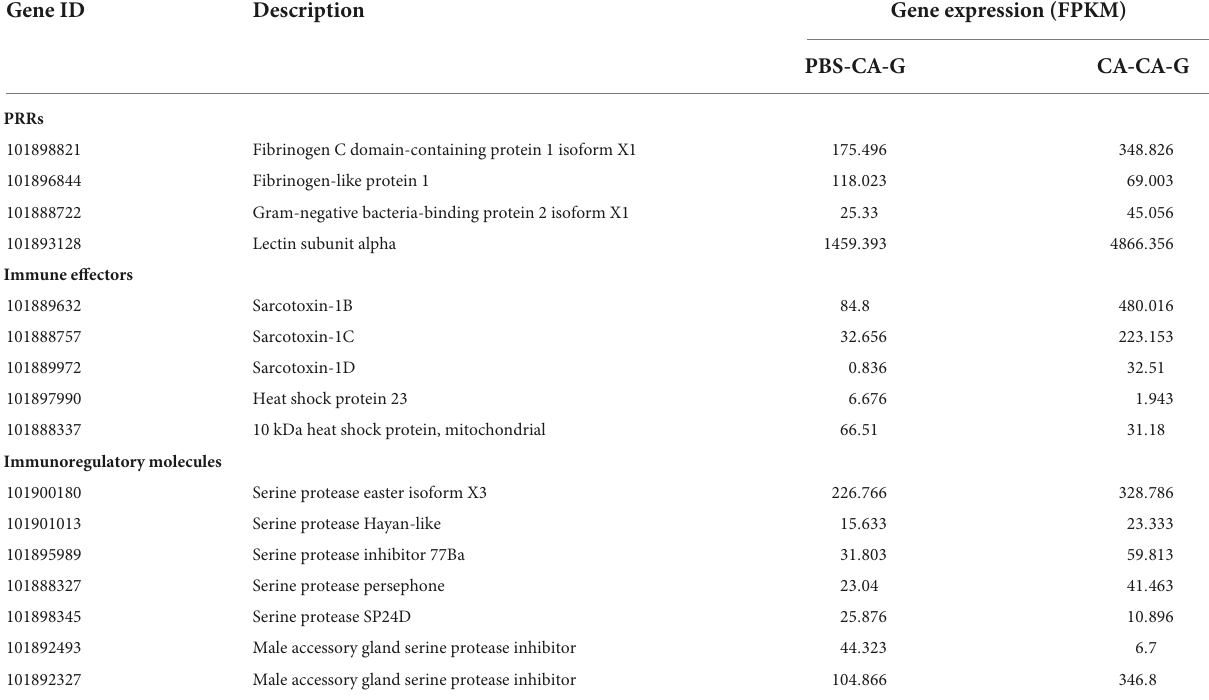
TABLE 2 Expression of differentially expressed immune genes in